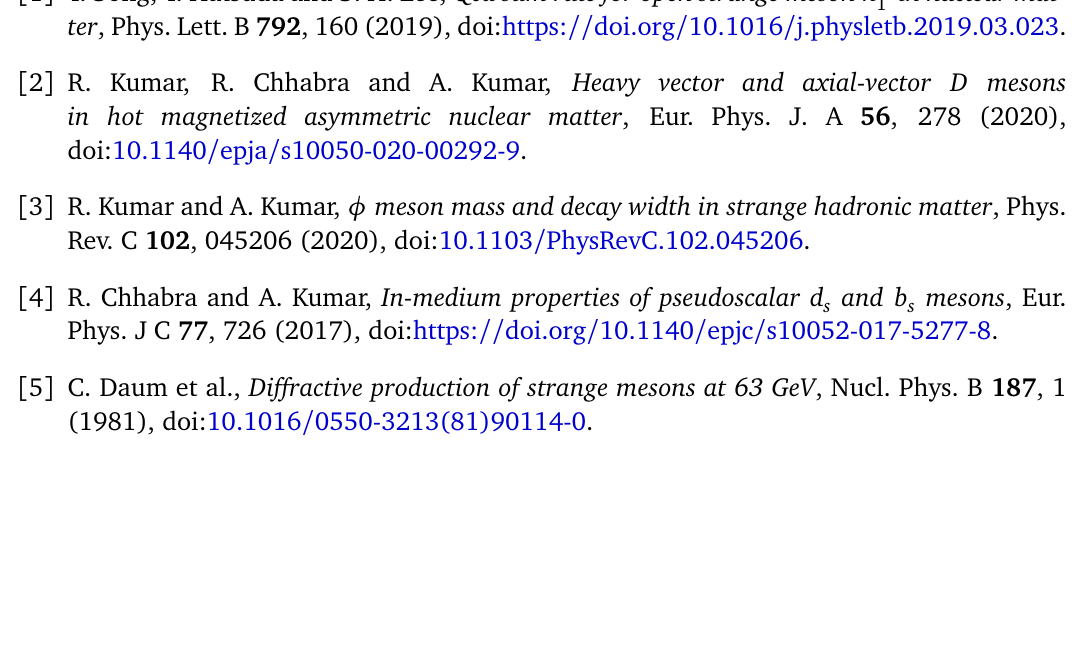
Table 2: In-medium values of shift in overlapping strength ∆ O ∗ (GeV), and, threshold parameter ∆ s ∗